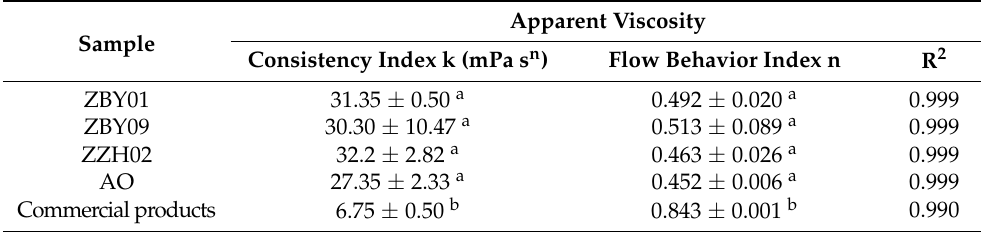
Table 4. Rheology properties of oat milk produced from different